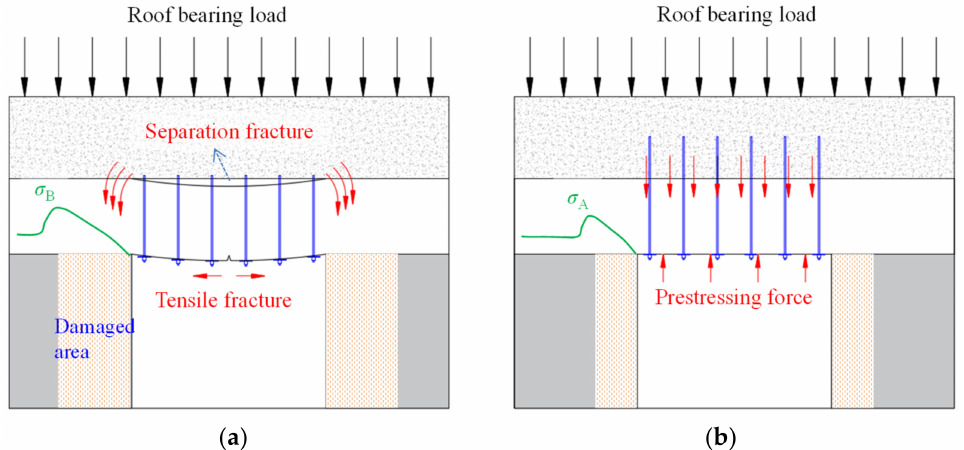
Figure 6. Deformation state of roof and rib caused by different length bolts: ( a ) short bolts; ( b ) long